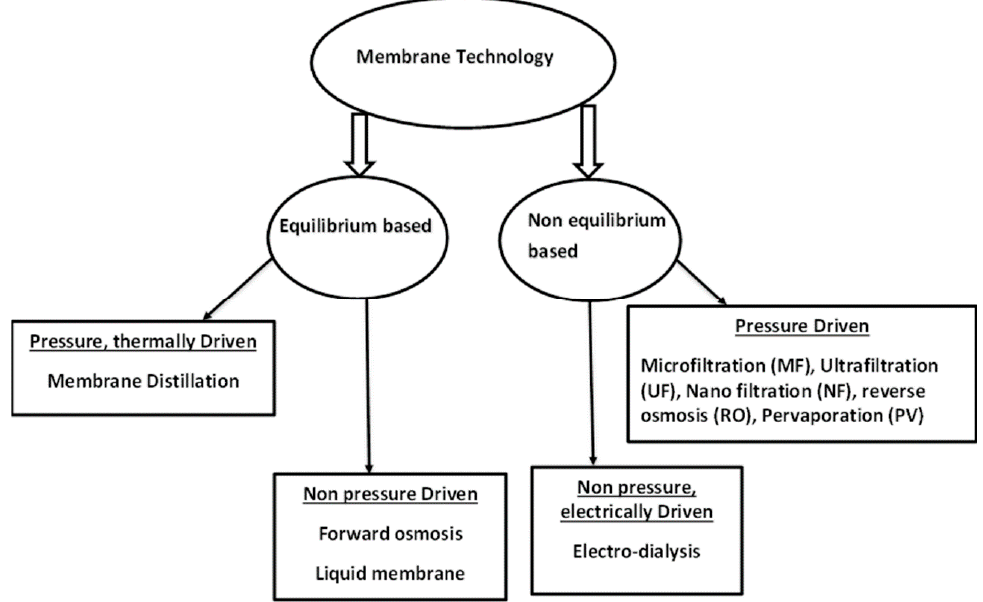
Figure 4. Schematic representation of the membrane processes adapted and modified from Obotey Ezugbe and Rathilal [49].